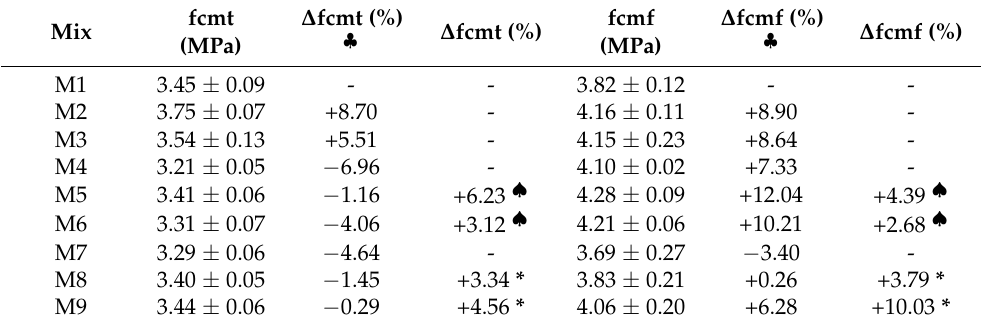
Table 8. Tensile and flexural strength of concretes 28 days